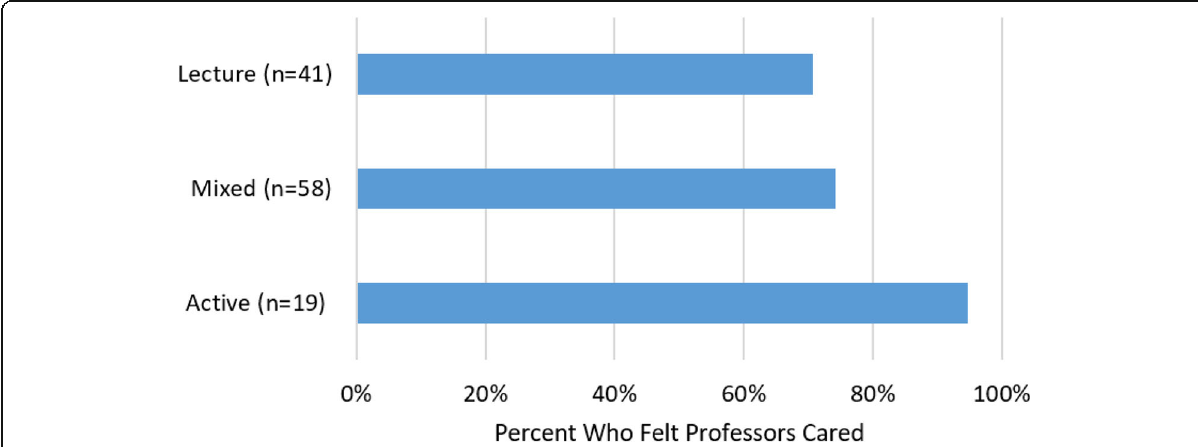
Fig. 10 Perceived instruction style and professor